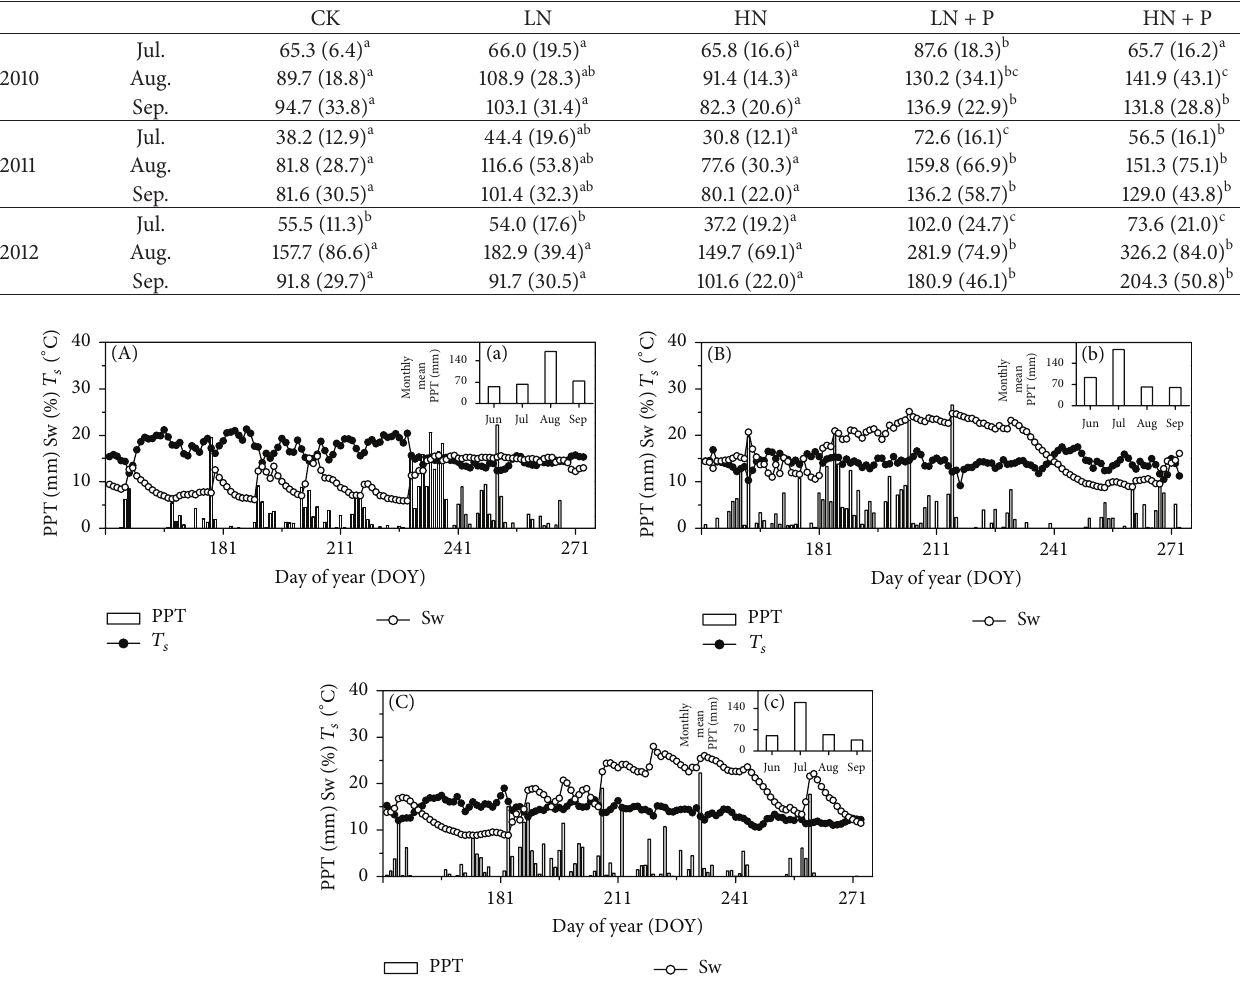
Table 2: Monthly means (data in the parentheses represent the SE, 𝑁 = 4 ) of aboveground biomass (AGB) in 2010, 2011, and 2012. Different letters in the same month within the same year indicate significant difference ( 𝑃 < 0.05 ) in monthly averages among treatments. See Figure 1 for abbreviations.